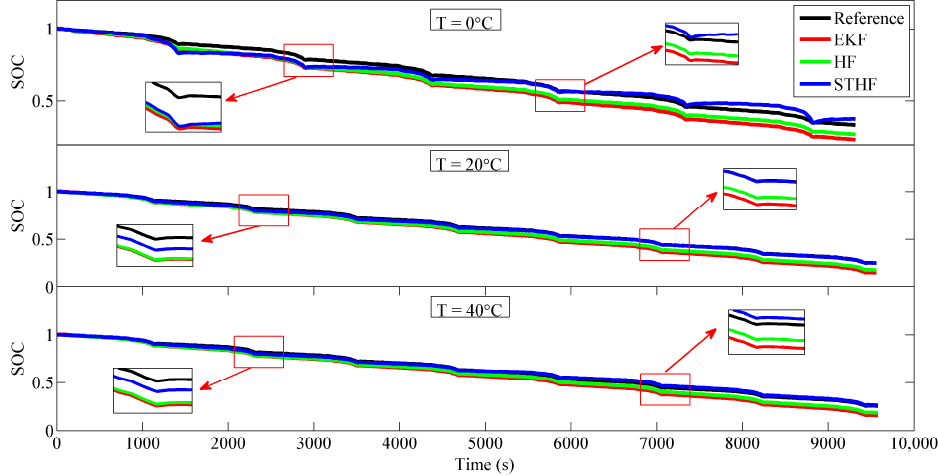
Figure 10. Estimation results of STHF, HF, and EKF with 0.1 A current-biased noises.